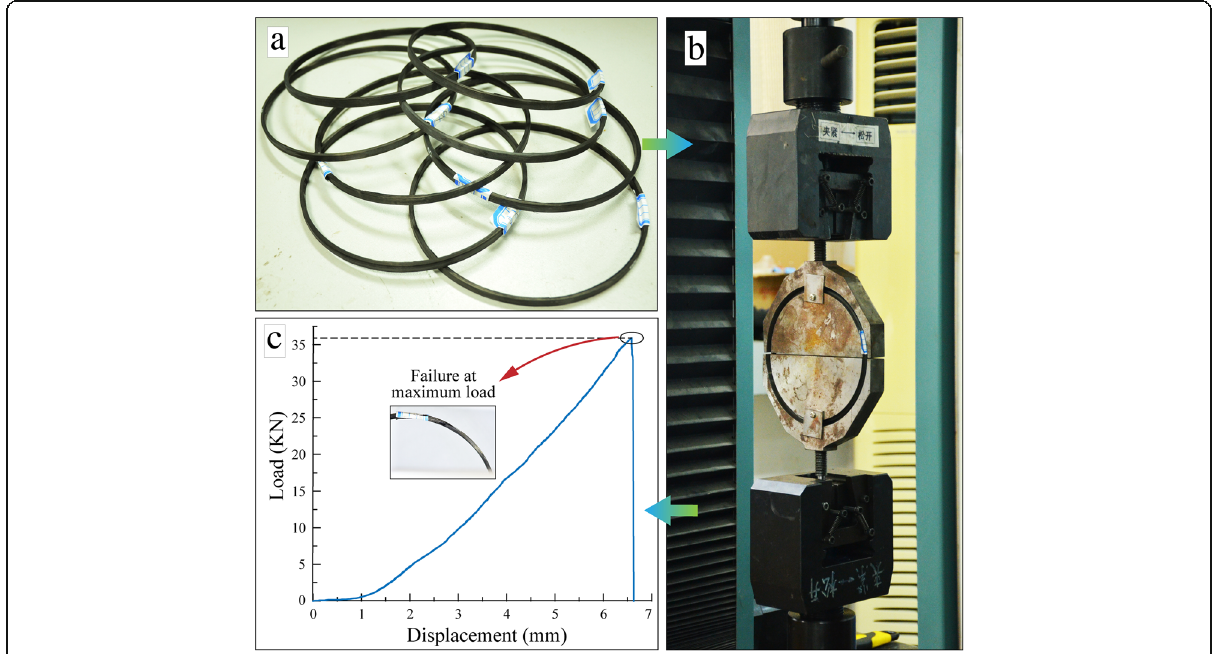
Fig. 3 Experiment test samples machining and tensile strength testing process. a Standard testing ring. b Electronic universal testing machine DDL100. c Force- displacement tensile